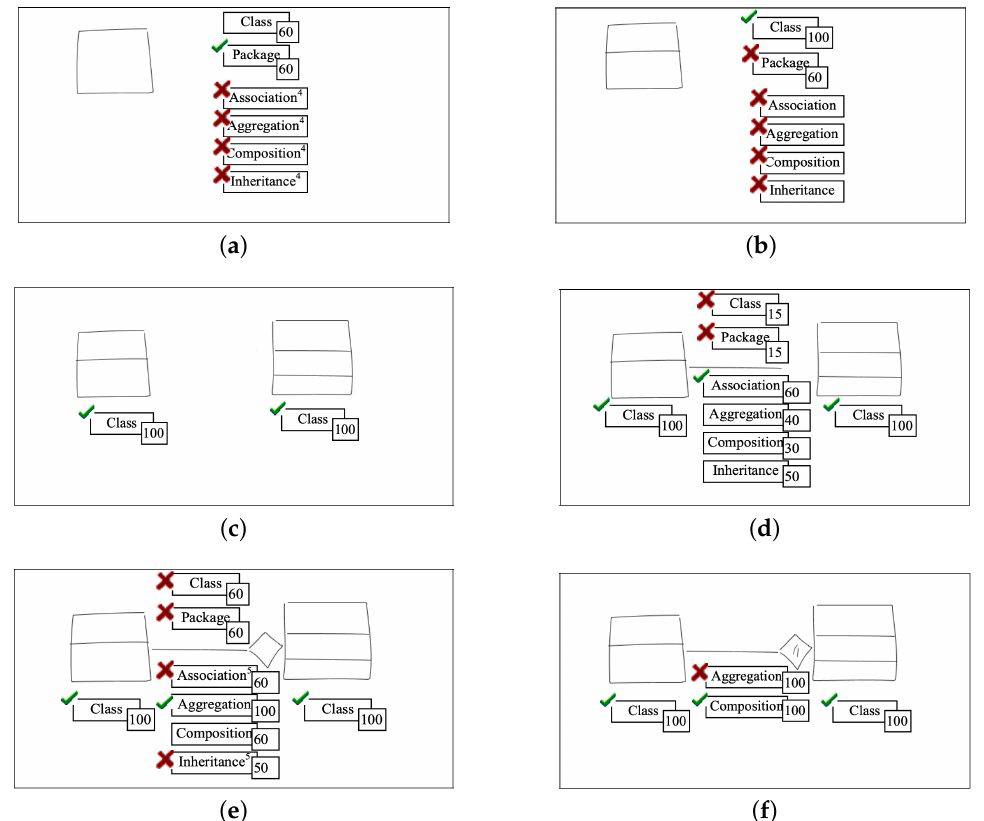
Figure 10. The incremental recognition of a class diagram. ( a ) The square is parsed by Class and Package recognizers with a discriminant rate of 60. ( b ) Only the Class recognizer is able to compound the line within the square to the previously recognized strokes. ( c ) The same recognition process is applied to the second Class symbol. ( d ) The language recognizer interprets the line between the two class symbols as Association since the corresponding recognizer obtains the highest discriminant value. ( e ) The rhombus near the line is compounded to the previous stroke by Composition and Aggregation recognizers. ( f ) The strokes drawn inside the rhombus lead to the recognition of a Composition